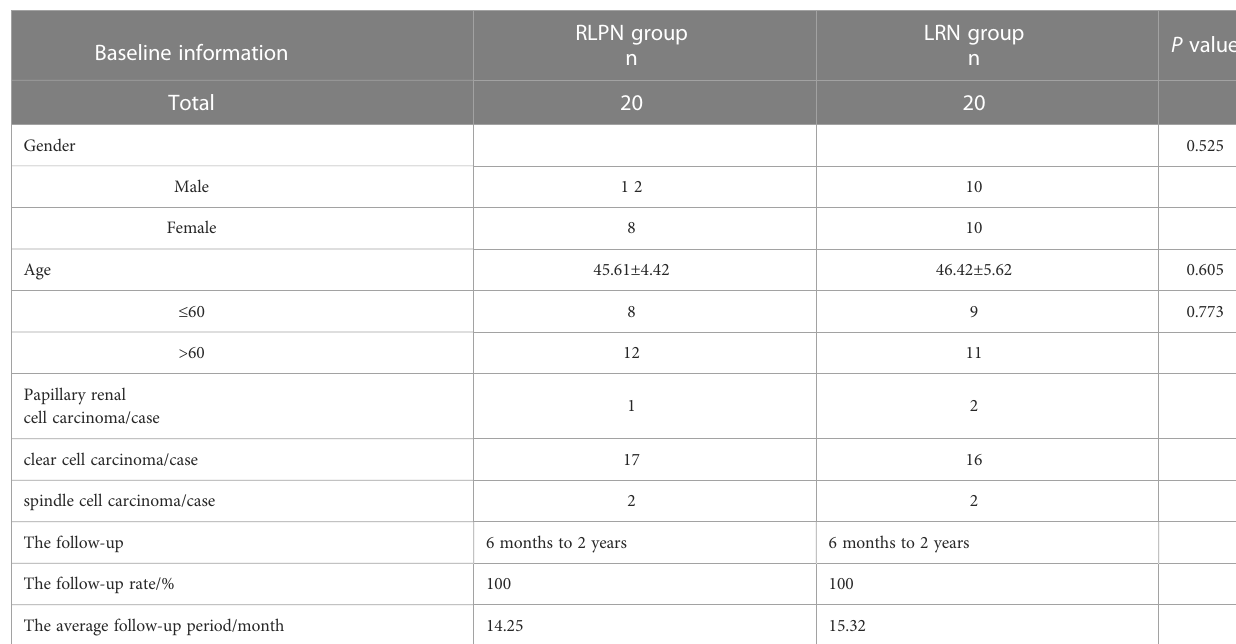
TABLE 1 Analysis of baseline data.